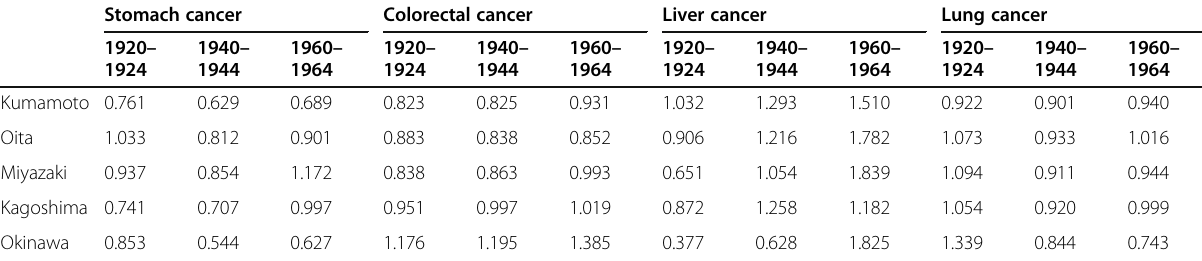
Table 4 Mortality rate ratio of a prefecture to all of Japan on each cohort in men (Continued) Stomach